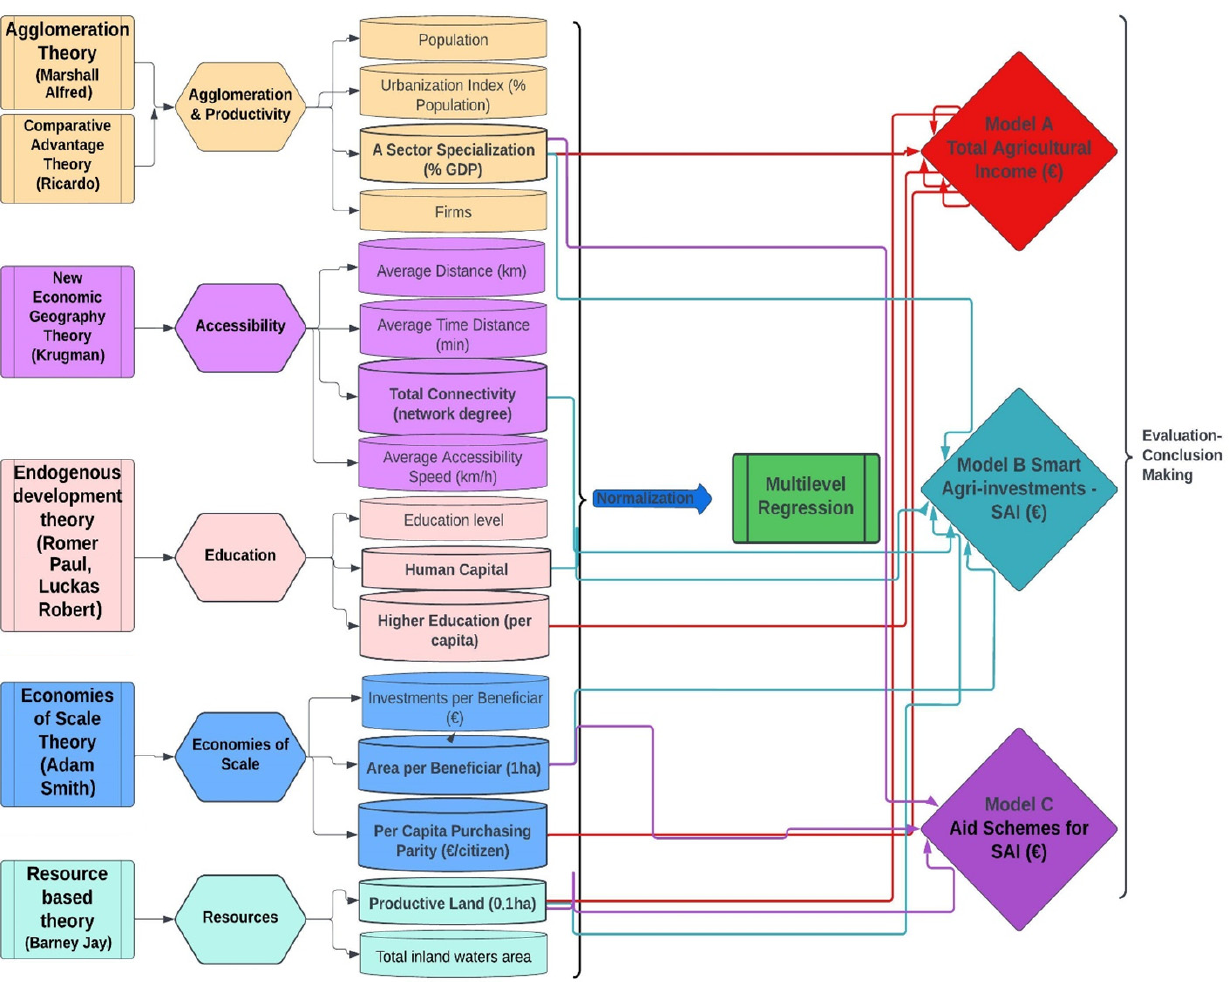
Figure 2. Flow chart showing the methodological framework of the study designed with Lusid- chart own elaboration (Lusid Software Inc., Salt Lake City, UT, USA, https://lucid.app/lucidchart/ (accessed on 2 February 2023)).